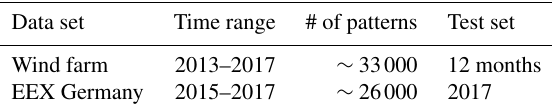
Table 1. Historical wind power data used for the experiments. For the wind farm, 12 random months were held back as test data. The time ranges include start and end years, but contain periods of miss- ing data. One training pattern per hour was generated for these ex- periments.